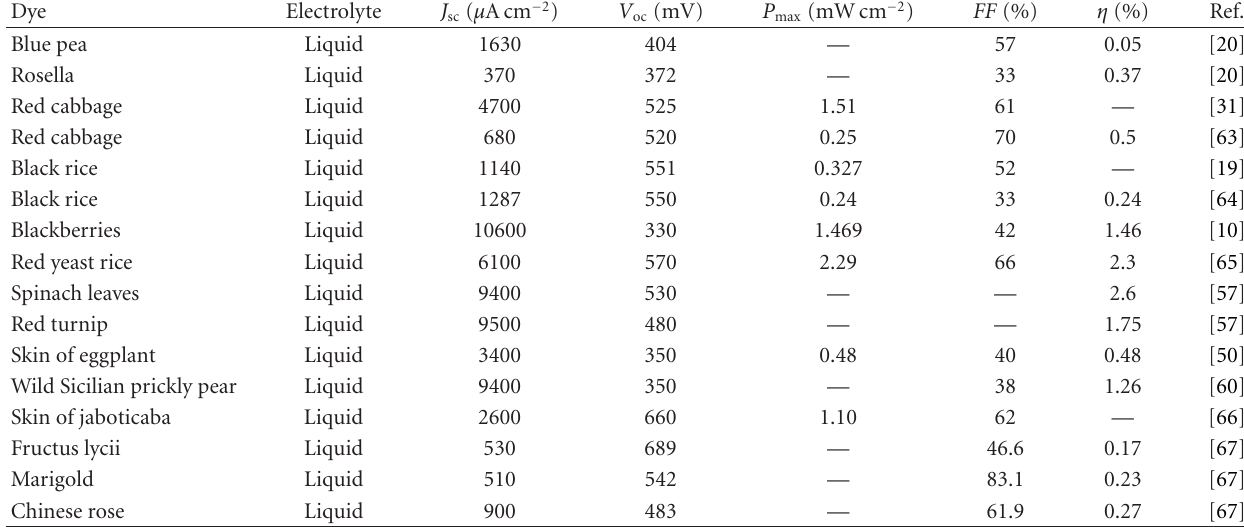
Table 5: DSSC properties sensitized with natural